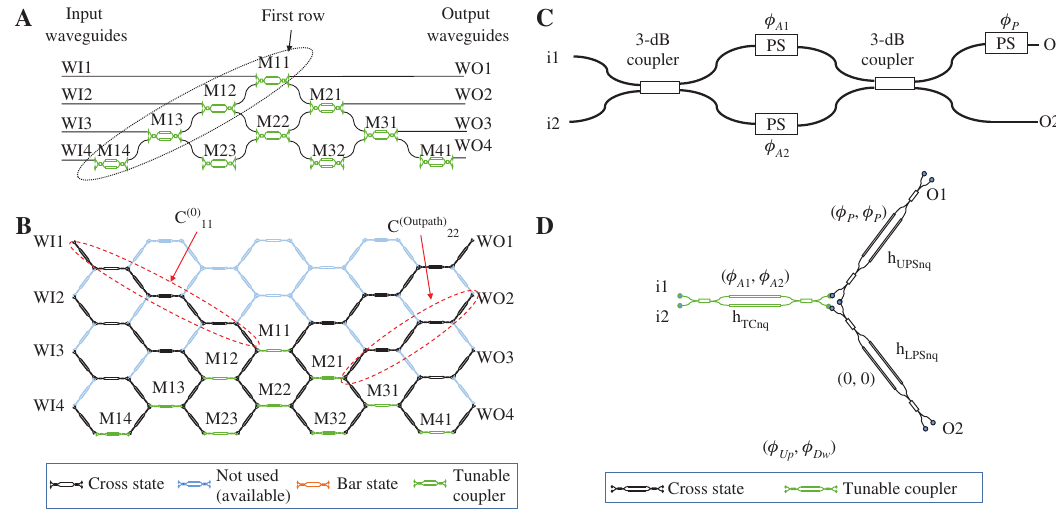
Figure 6: Layout and emulation using the hexagonal waveguide mesh of a triangular 4 × 4 universal interferometer. (A) Classical triangular arrangement and (B) hexagonal mesh-based implementation of a 4 × 4 interferometer. (C) Beamsplitter for the classi- cal approach and (D) corresponding beamspliter implementation with three TBUs for the hexagonal waveguide mesh.